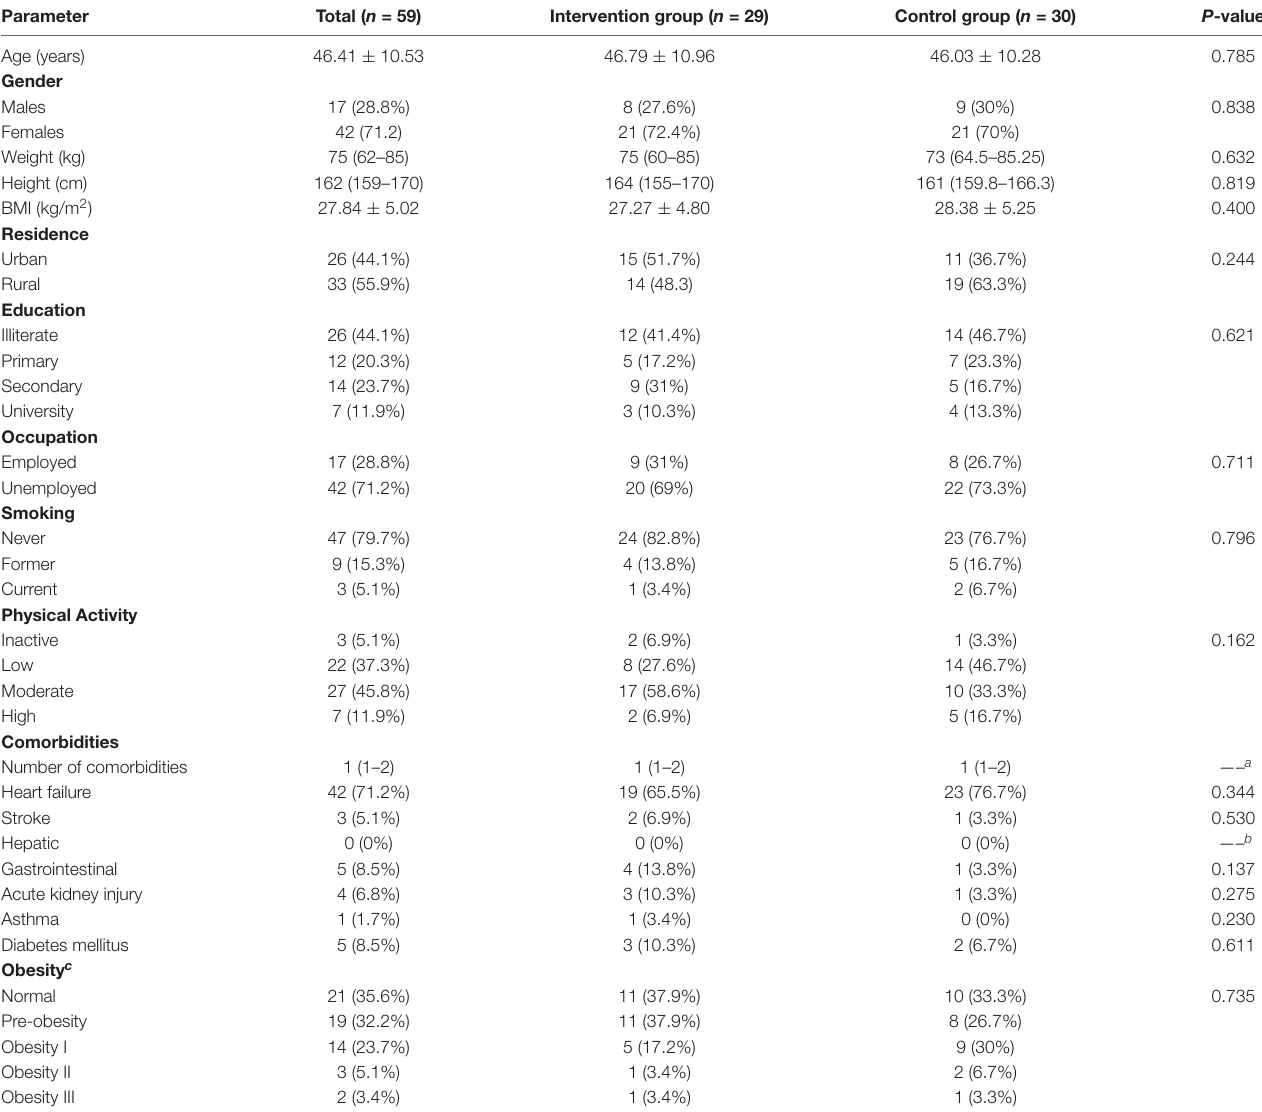
TABLE 2 | Baseline demographic data of the study